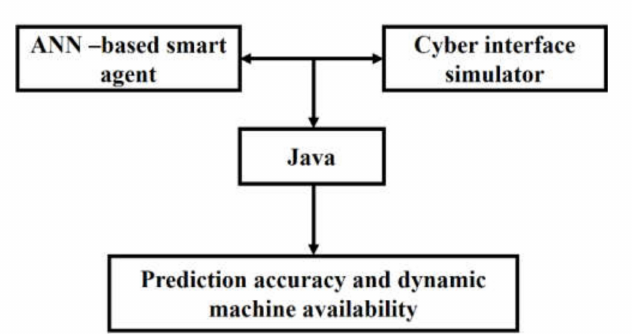
Figure 14. Dynamic 3D printing machine identification